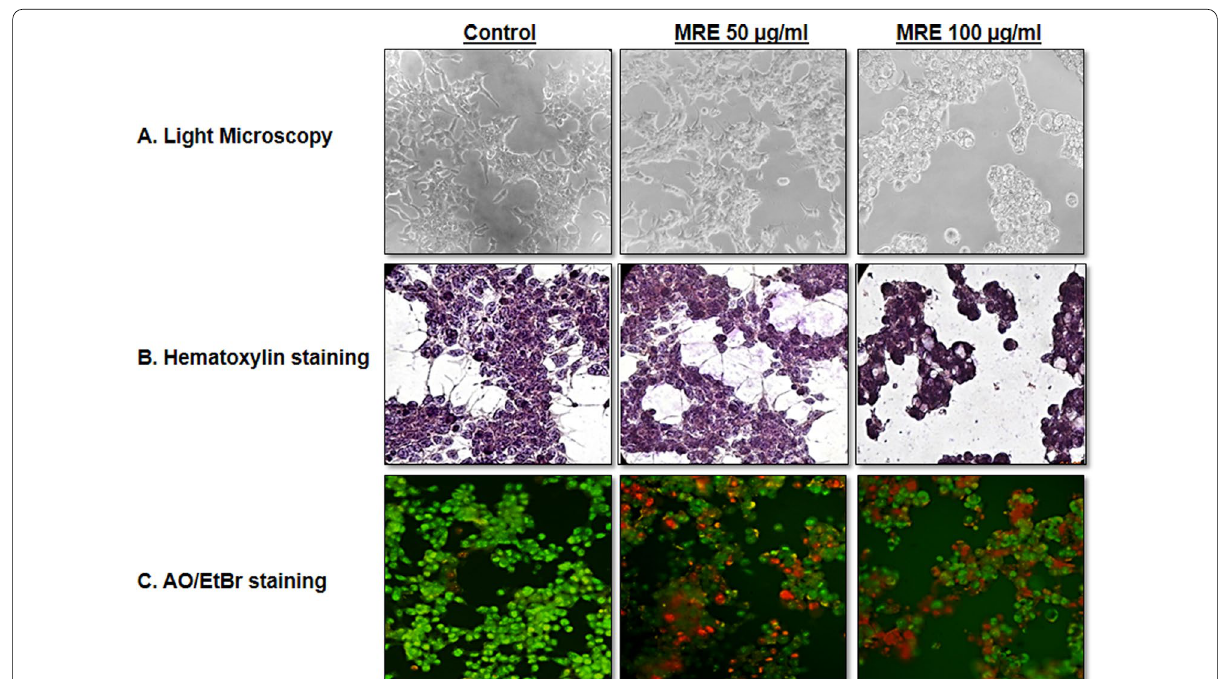
Fig. 2 Mangosteen rind extract (MRE)-induced changes of morphology and viability of MCF-7 cells. MCF-7 cells were treated with MRE at different concentrations (0, 50, and 100 μg/ml) and observed through light microscope for morphological variations under 40X magnification ( A ), stained with hematoxylin (nuclear stain) and were observed under light microscope ( B ), stained with AO/EtBr dual staining and the apoptotic cells were observed using 40X magnification under fluorescence microscope ( C